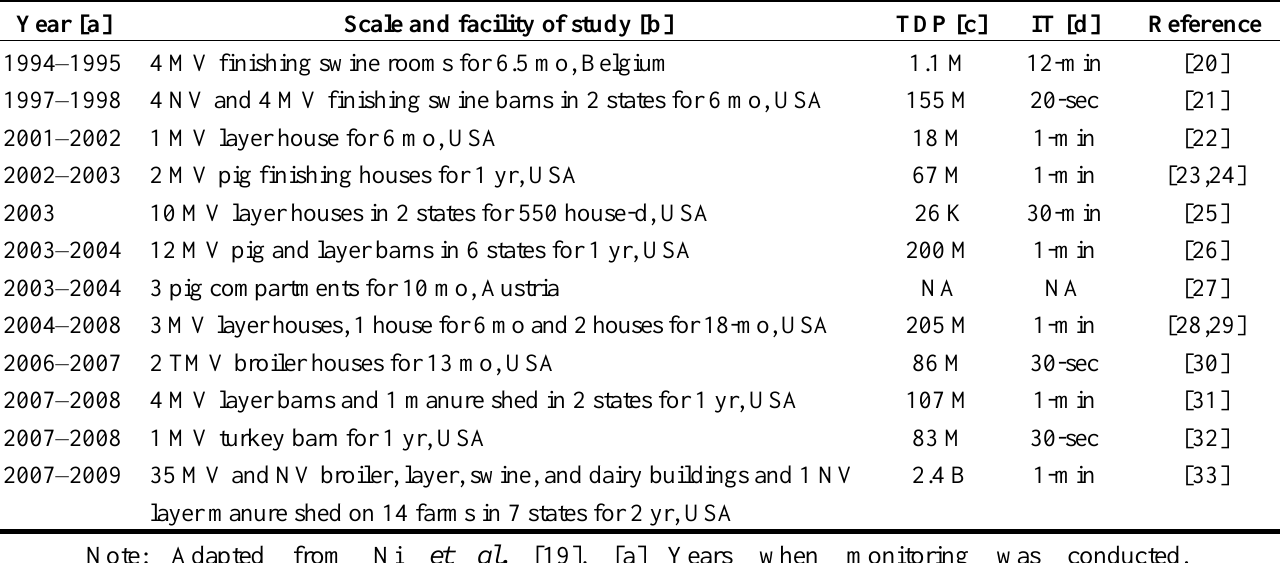
Table 1. Reported long-term (>6 months) and continuous on-farm ammonia emission